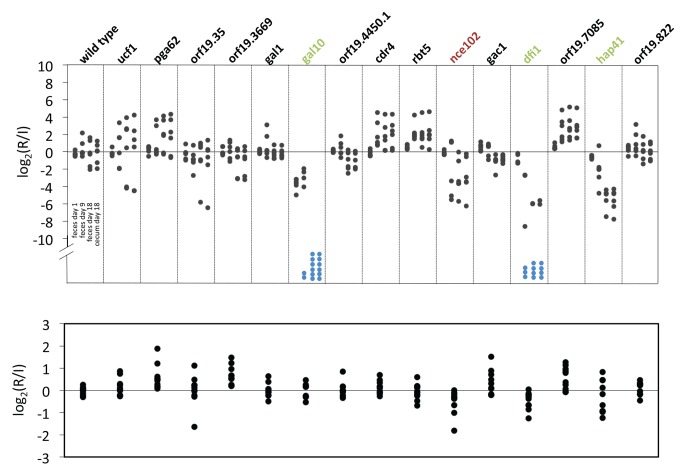
Target genes required for proliferation in the host.GI tract colonization (top) and systemic infection (bottom) analyses of selected target genes upregulated in the GI tract and controlled by both HMS1 and RTG1/3. Blue dots represent samples below the qPCR detection level. Mutants with statistically significant GI tract colonization impairment are in green; statistically significant systemic infection defect is indicated in red.